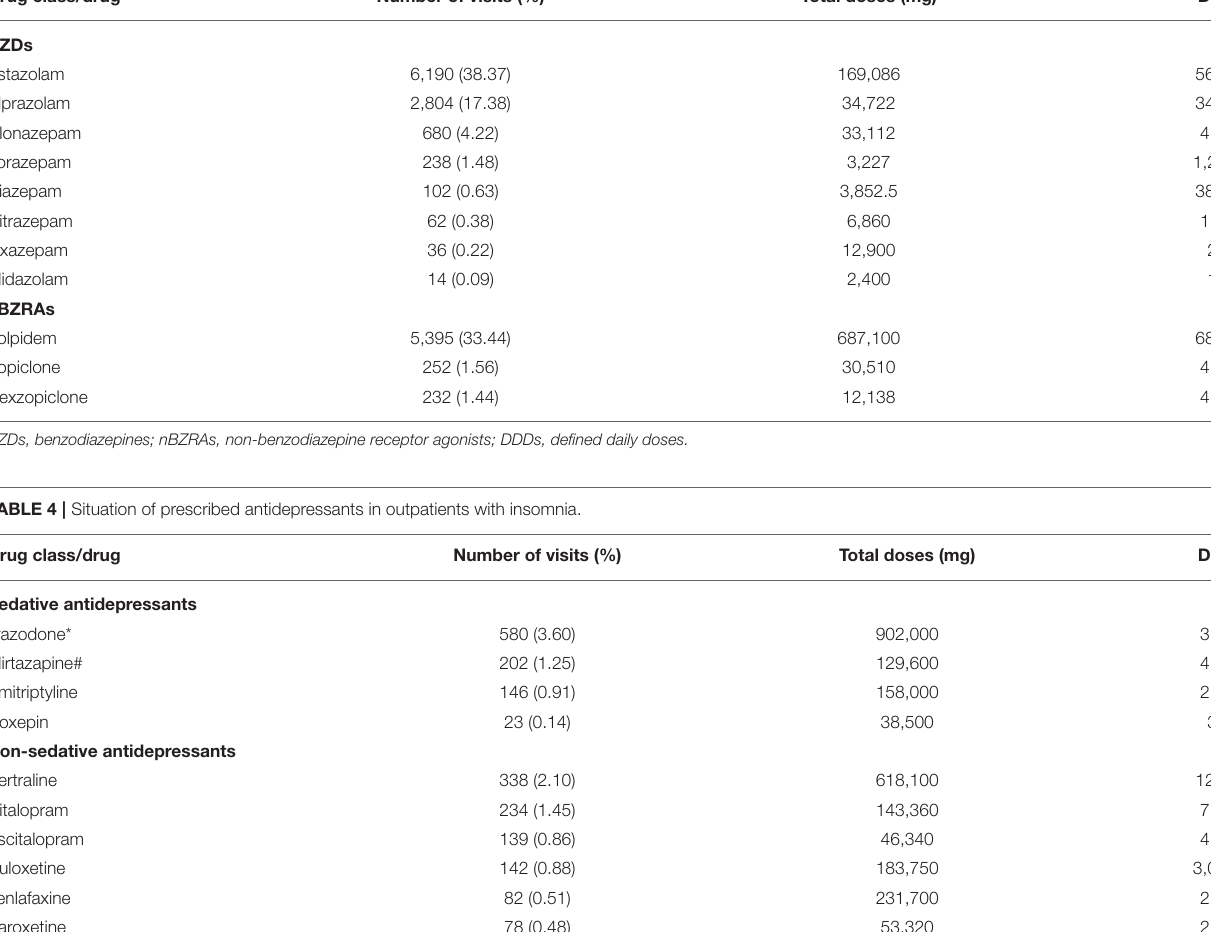
TABLE 3 | Situation of prescribed benzodiazepine receptor agonists in outpatients with insomnia. Drug class/drug